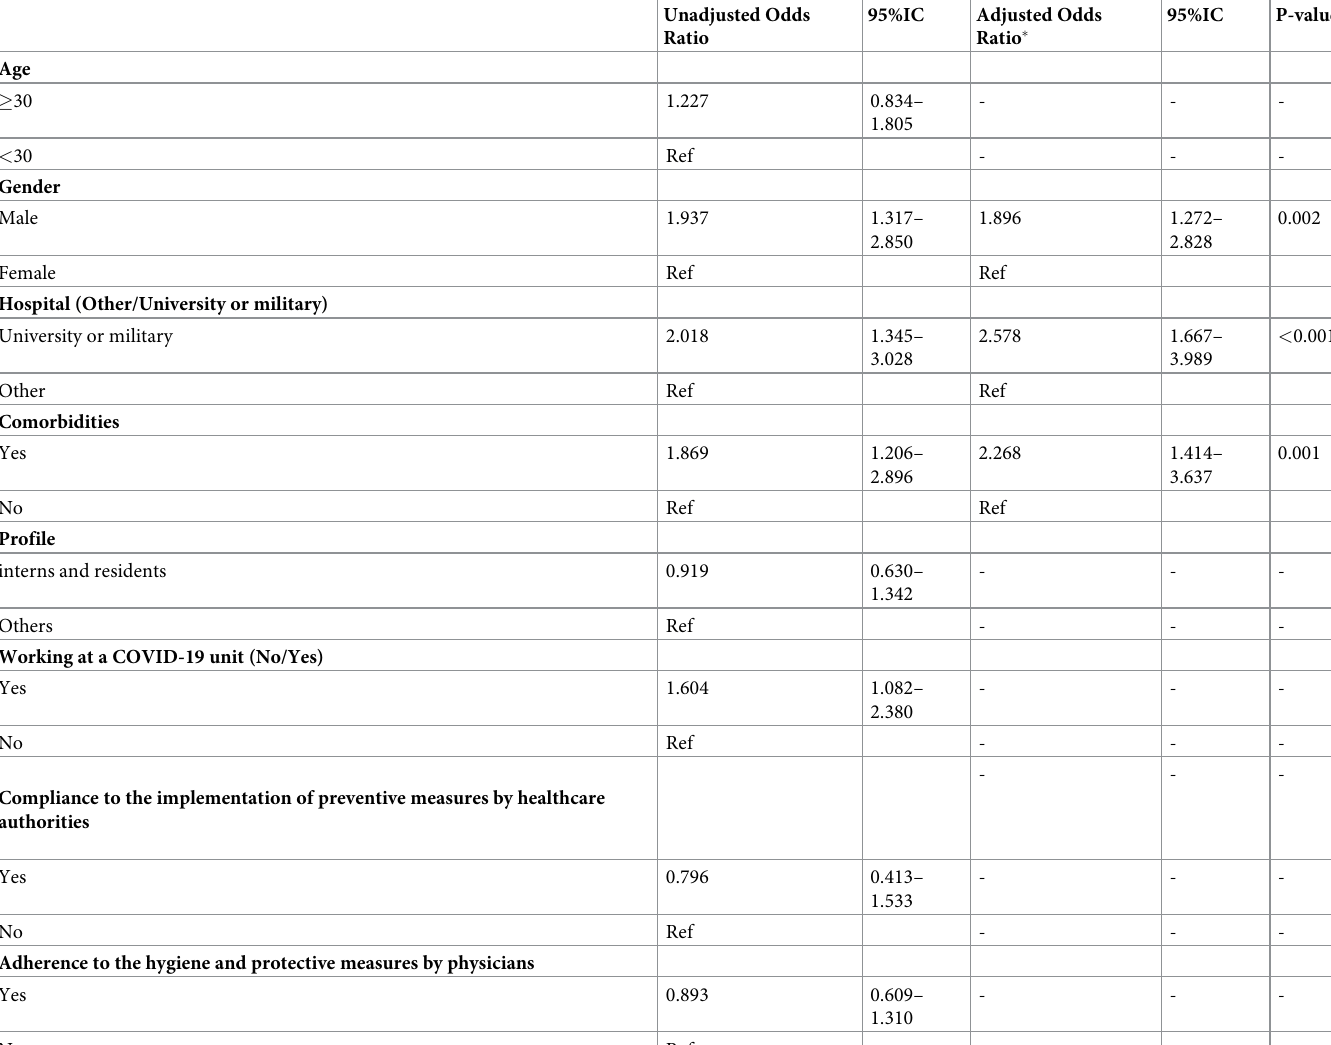
Table 3. Univariate and multivariate analysis between infection with COVID-19 with socio-demographic characteristics and adherence to hygiene and protection